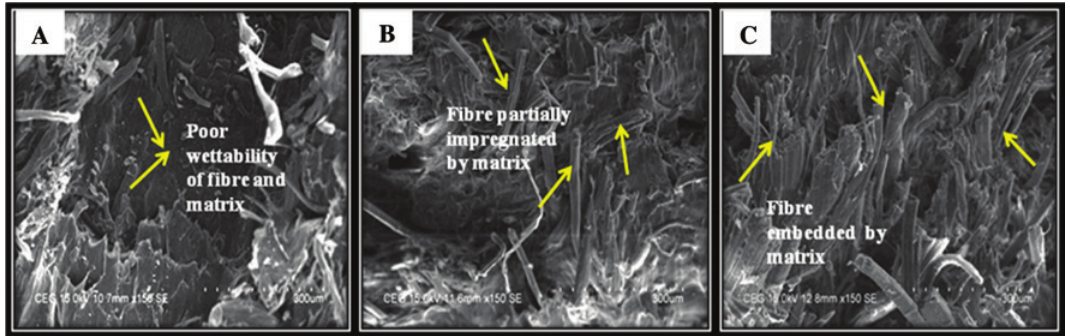
Figure 4: SEM images of the tensile fracture